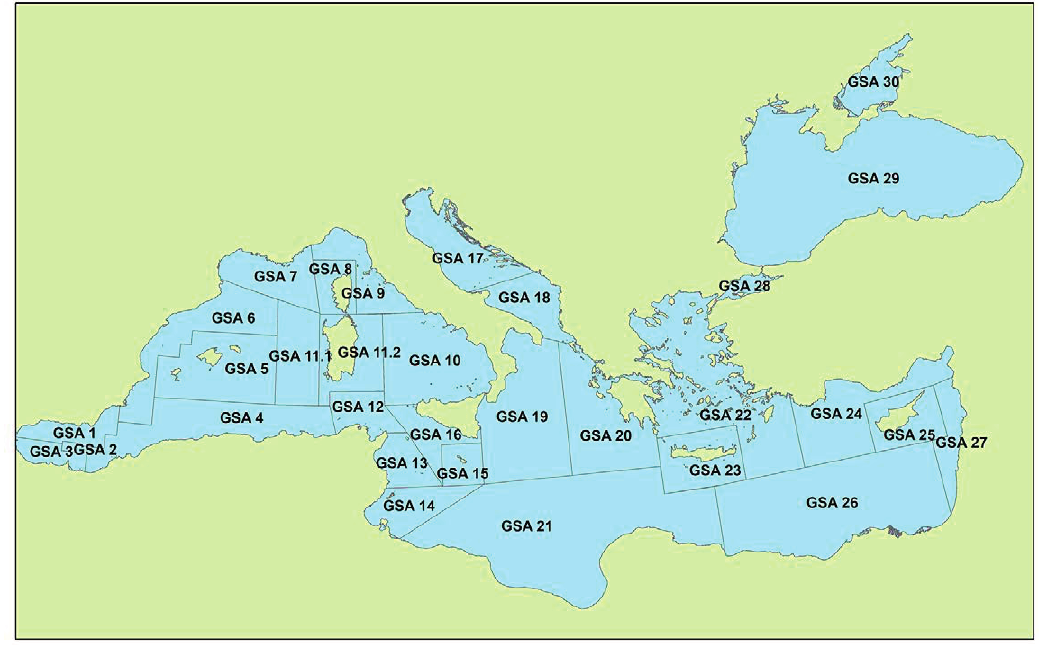
Fig. 1. – Geographical subareas (GSAs) in the General Fisheries Council for the Mediterranean (GFCM) area. The Mazara del Vallo trawlers operate in GSAs 12 to 16 (northern Tunisia; Gulf of Hammamet; Gulf of Gabes; Malta; southern Sicily) and 21 to 25 (southern Ionian Sea; Aegean Sea; Crete; northern Levant Sea;